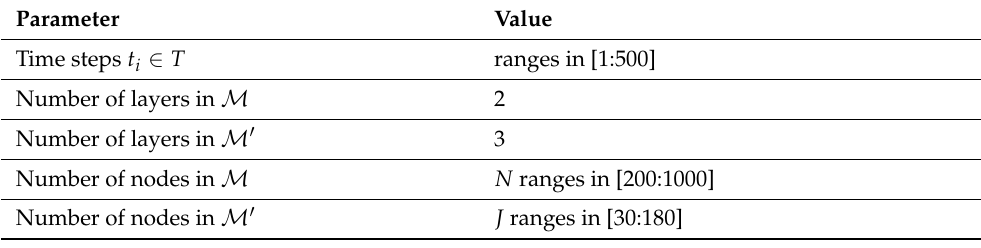
Table 3. Simulation parameters.